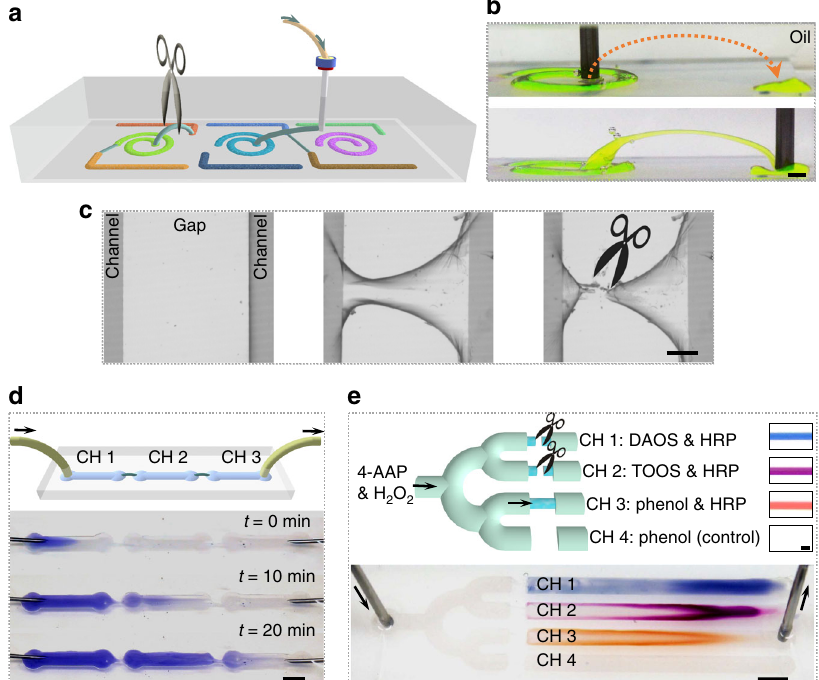
Fig. 4 Recon fi gurable 3D all-liquid microreactors with logical optical outputs. a Schematic of fabricating 3D microchannels stabilized by nanoclay- surfactant interfacial assembly to connect the separated microchannels by printing of water in oil. Disconnecting these microchannels is also possible by cutting these “ bridges ” off. b Adjacent channels on a patterned substrate connected by a 3D printed overpass. Na- fl uorescein (0.1 mg mL − 1 ) has been added to the clay dispersion to clarify features of the constructs. Scale bar: 2 mm. c Fabrication of a 3D bridge linking separate channels (middle panel) and clipping the bridge (right panel). Scale bar: 500 µ m. d Time-lapse showing a dyed solution pumped through liquid channels CH 1, CH 2, and CH 3, which are connected by printed 3D bridges. Scale bar: 5 mm. e Chemical transformations yielding chromogenically distinct products are conducted consecutively by forming and then breaking bridges between the inlet and various patterned channels containing different reagents. The bridges are built using liquid-in- liquid 3D printing to yield a “ turn-on ” state, and mechanically broken to yield a “ turn-off ” . Inset photographs on top show the solutions collected in capillaries after carrying out these chromogenic reactions in vials. DAOS: N -ethyl- N -(2-hydroxy-3-sulfopropyl)-3,5-dimethoxyaniline, sodium salt. TOOS: N -ethyl- N -(2-hydroxy-3-sulfopropyl)-3-methylaniline, sodium salt. Scale bars: 1 mm (top) and 5 mm